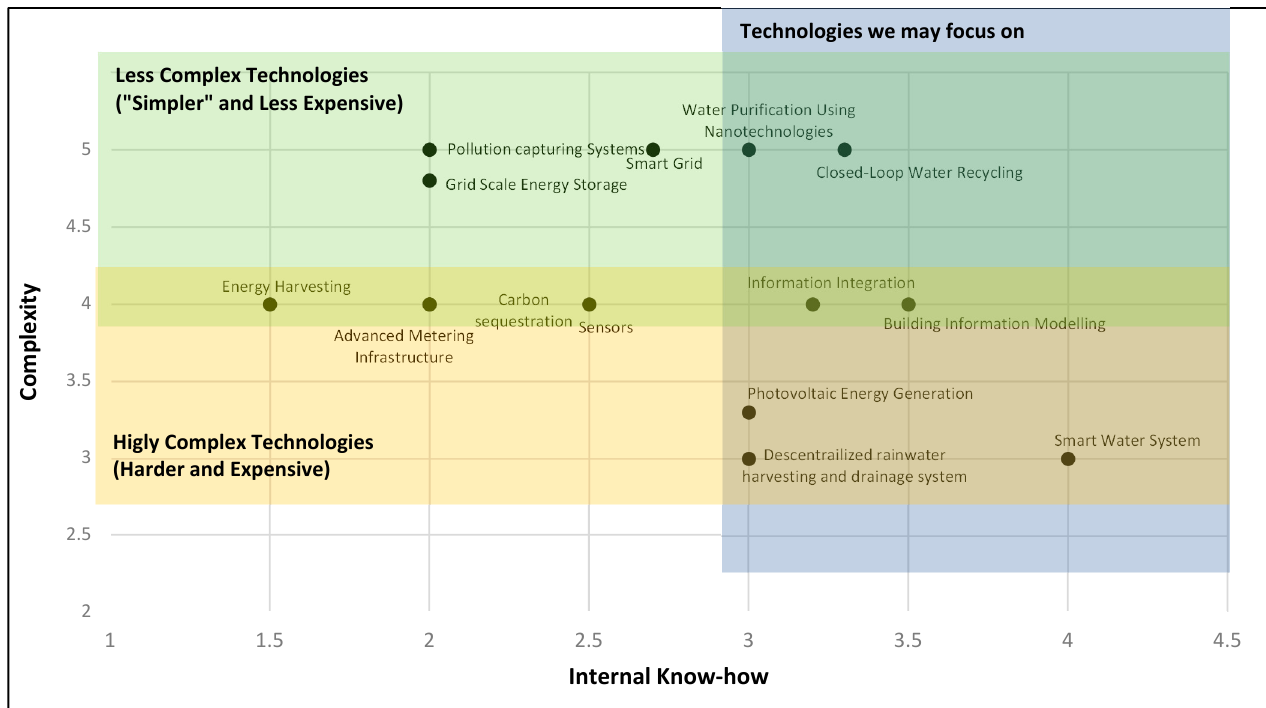
Figure 3. Potential impact vs. internal know-how.